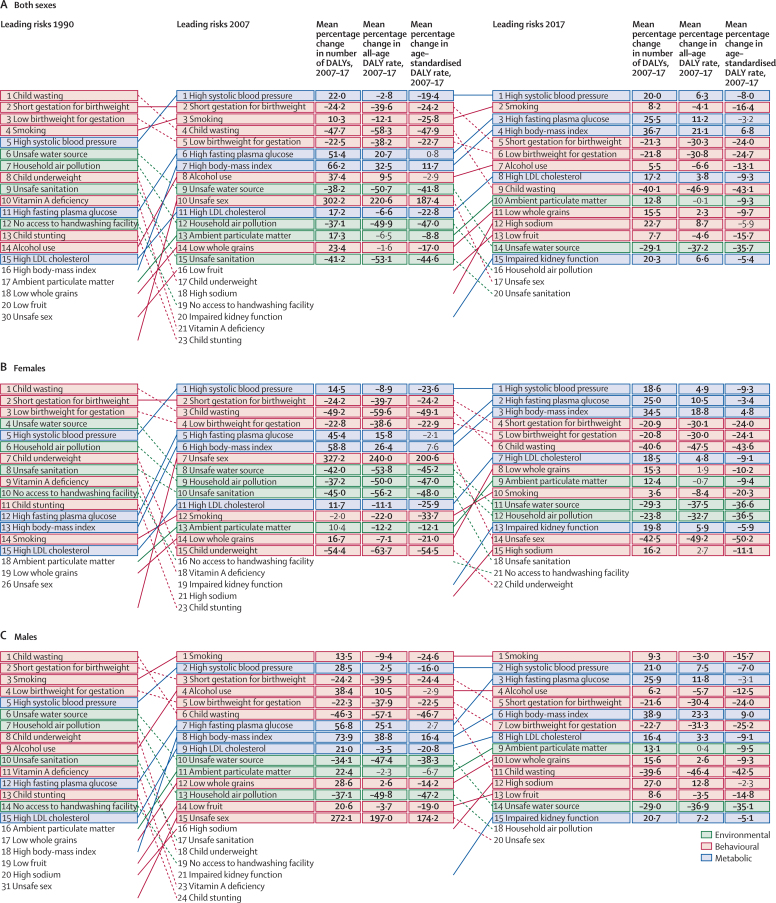
Leading 15 Level 4 risk factors by attributable DALYs at the global level, 1990, 2007, and 2017, for both sexes (A), females (B), and males (C)Risks are connected by lines between time periods; solid lines are increases and dashed lines are decreases. Statistically significant increases or decreases are shown in bold (p<0·05). DALYs=disability-adjusted life-years. LDL=low-density lipoprotein.